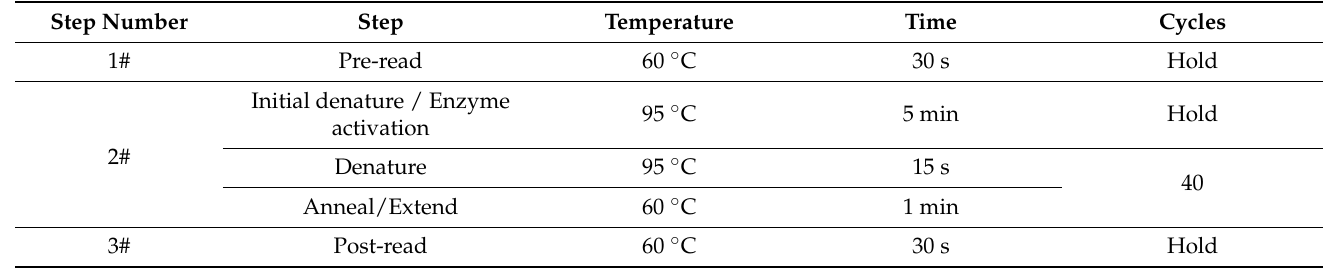
Table 3. Optimized real-time PCR protocol for Galc allelic